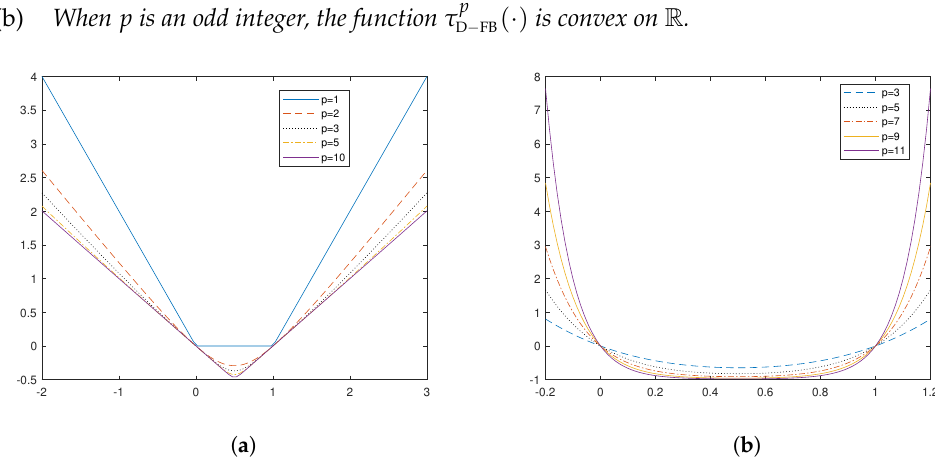
( x ) and τ p ( x ) with different p . ( a ) Graph of τ p Figure 1. Graph of τ p FB D − FB ( x ) with different values of p . ( b ) Graph of τ p D − FB